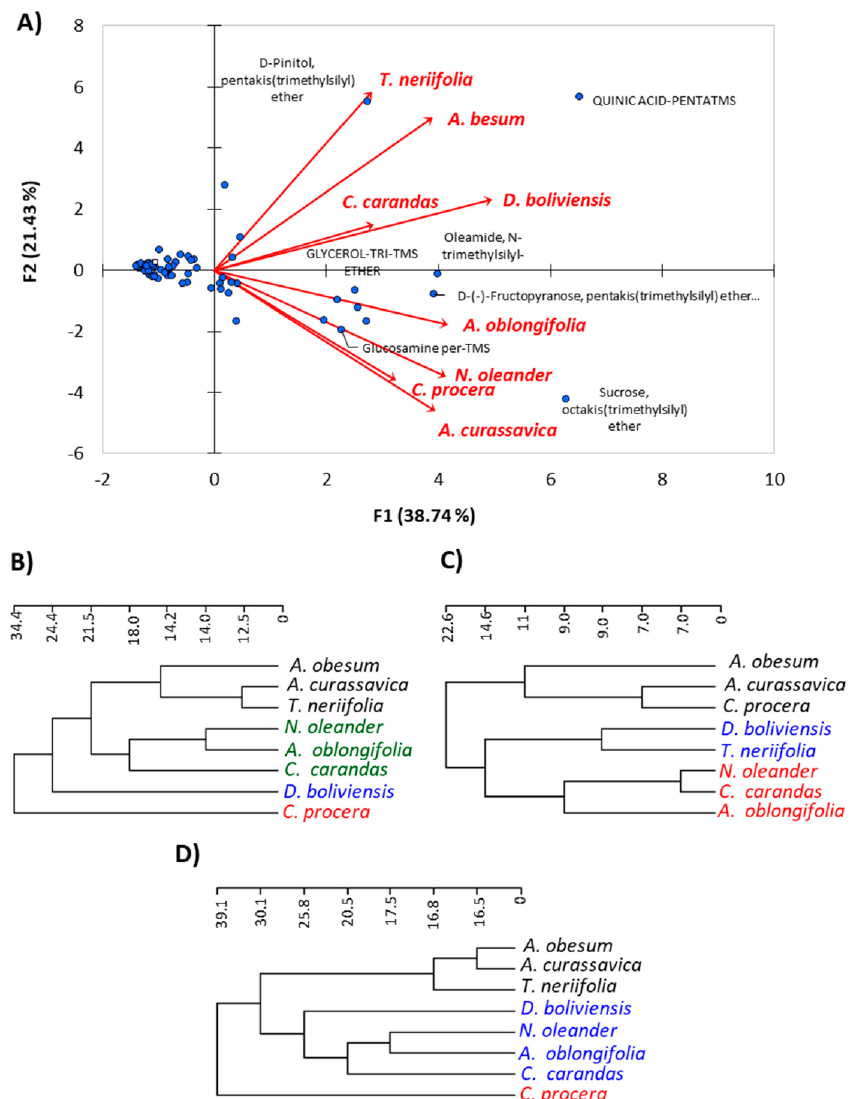
Figure 6. Correlation analysis of the studied Apocynaceae species. ( A ) Principal component analysis (PCA) based on the chemical composition; ( B ) hierarchical clustering (Ward’s method to the Euclidean distances) based on macro-, micro-morphological, and anatomical characteristics; ( C ) cluster analysis of chemical characteristics; and ( D ) cluster analysis of all merged